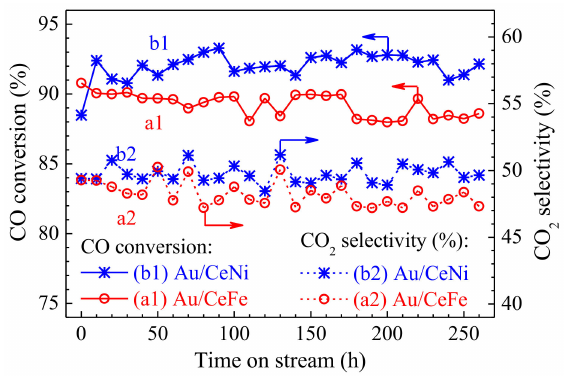
Figure 12. Long-term test of CO PROX over Au/CeFe ( a1 , a2 ) and Au/CeNi ( b1 , b2 ) catalysts at 80 ◦